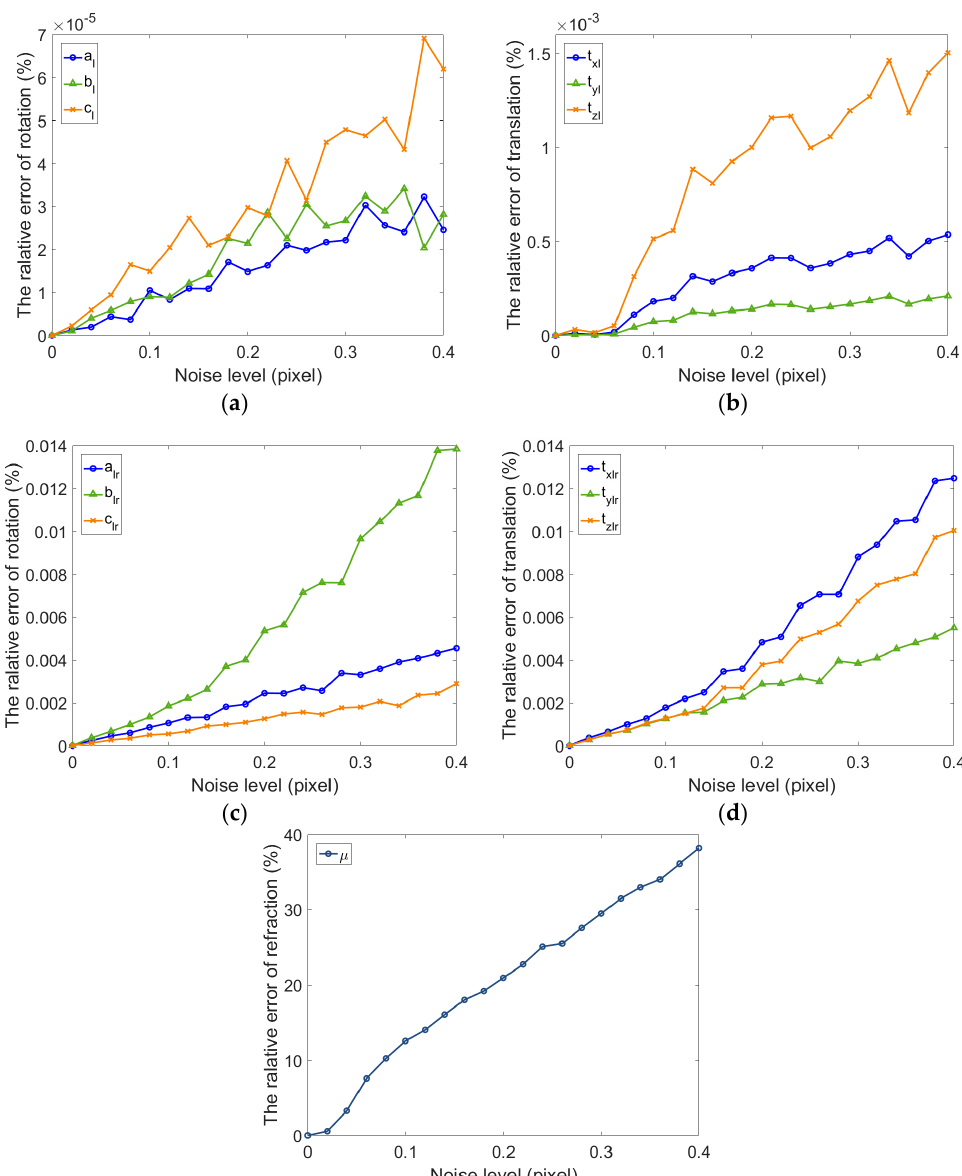
Figure 8. The relative error of extrinsic parameters for binocular cameras with refraction estimation. ( a ) Relative error for the rotation vector of the left camera; ( b ) Relative error for the translation vector of the left camera; ( c ) Relative error for the rotation vector of the left and right camera; (dRelative error for the translation vector of the left and right camera; ( e ) Relative error for the refraction index.